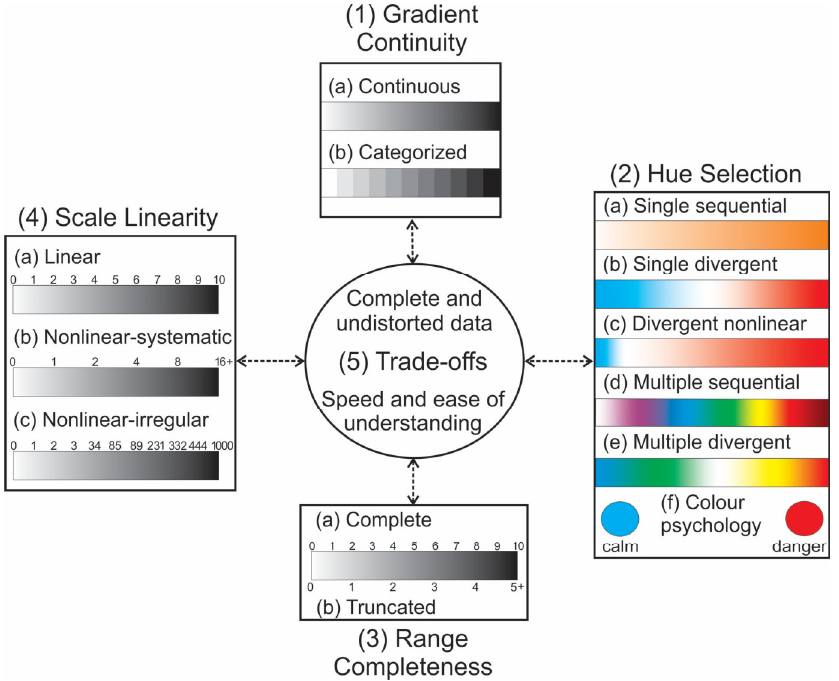
Figure 2. Illustration of the design options (rectangles), which are described in the text, and trade-offs (circle) that are made when categorizing and colouring data that are on a numerical scale of measure.